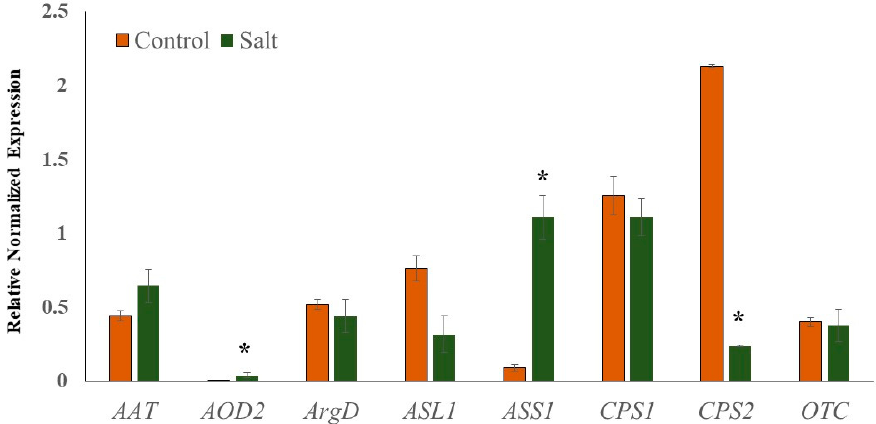
Figure 7. Quantitative real-time PCR (RT-qPCR) analysis.). Relative expression profiles of genes involved in the citrulline metabolic pathways in seedling leaf tissues of Crimson Sweet due to salt stress. The error bars are the means ± SE ( n = 3), and asterisks (*) represent significant differences between treated and control tissues ( p < 0.05).